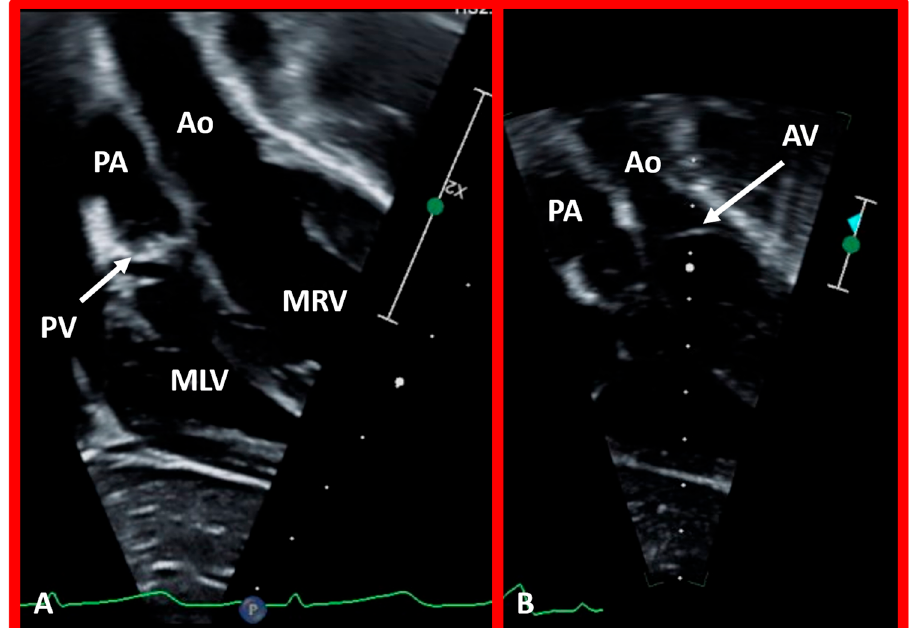
Figure 40. Echo images in apical four-chamber projections of a child with ventricular inversion. The aortic valve (AV) and aorta (Ao) are located to the left of the pulmonary valve (PV) and pulmonary artery (PA), indicating an l-loop, and that morphologic right ventricle (MRV) is on the left, and the morphologic left ventricle (MLV) is on the right. In ( A ), the PV (arrow in ( A )) is clearly seen, while AV is imaged in ( B ) (arrow in ( B )).